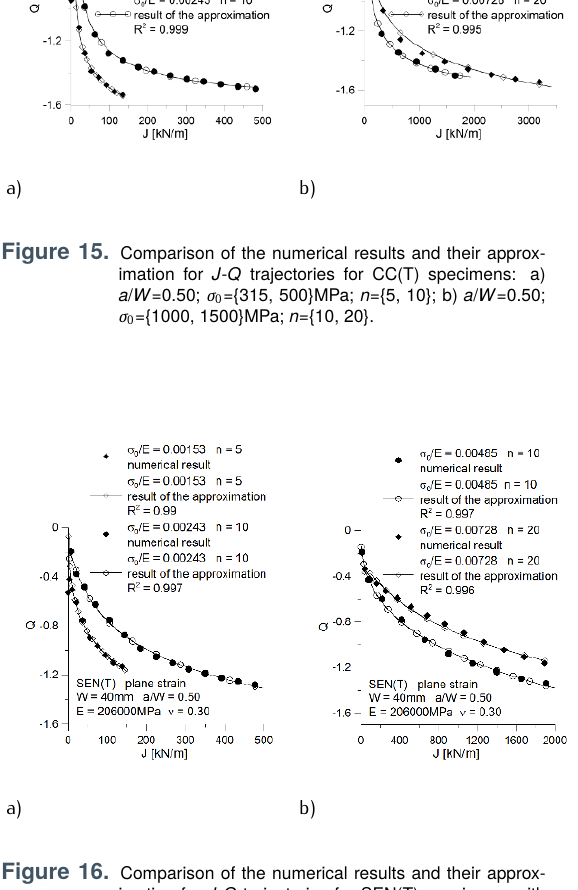
Figure 16. Comparison of the numerical results and their approx- imation for J - Q trajectories for SEN(T) specimens with relative crack length a / W =0.50: a) σ 0 ={315, 500}MPa, n ={5, 10};b) σ 0 ={1000, 1500}MPa, n ={10,